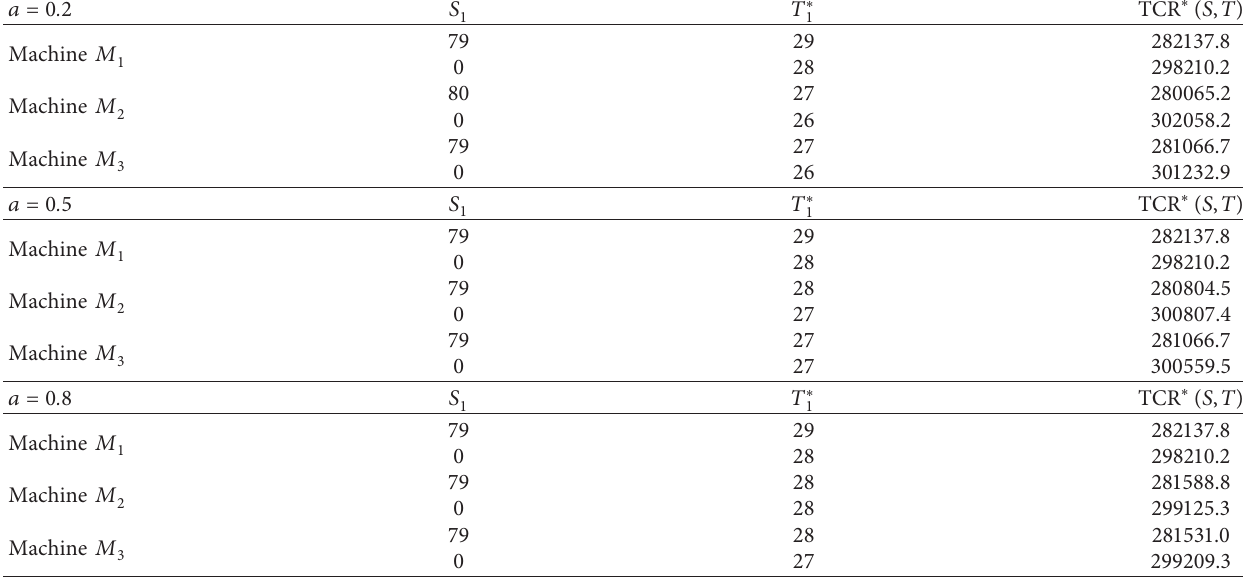
Table 10: Comparison of two maintenance strategies for a � 0 . 2, a � 0 . 5, and a � 0 . 8. a � 0 .